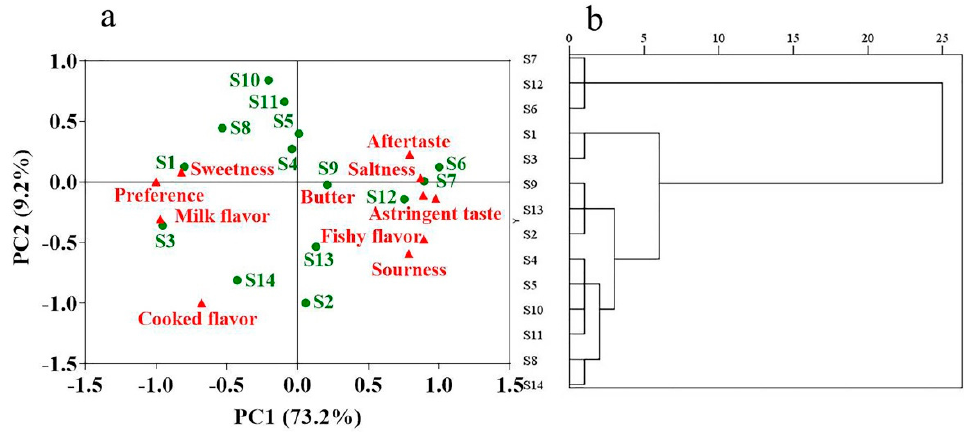
Figure 4. Classification of milk power samples from different brands currently marketed in China. ( a ) Biplots based on the results of principal component analysis from the descriptive analysis of fourteen milk powder samples. The first two dimensions of the biplot explained 82.4% of the variation among the samples. ( b ) Dendrogram of cluster analysis. Graphical representation of samples from consumer preference on fourteen infant formula milk powder samples.